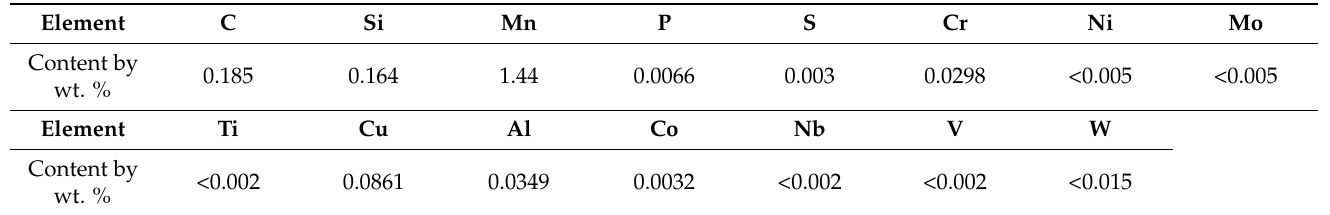
Table 2. Chemical composition of the tested samples made of the S355J2+N steel (according to